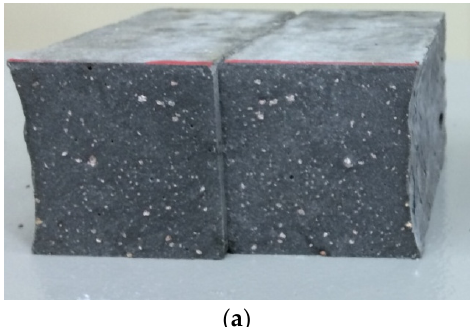
Figure 5. Mortar flexural strength versus microcapsule concentration at 7 curing days (Error bars = standard deviation).